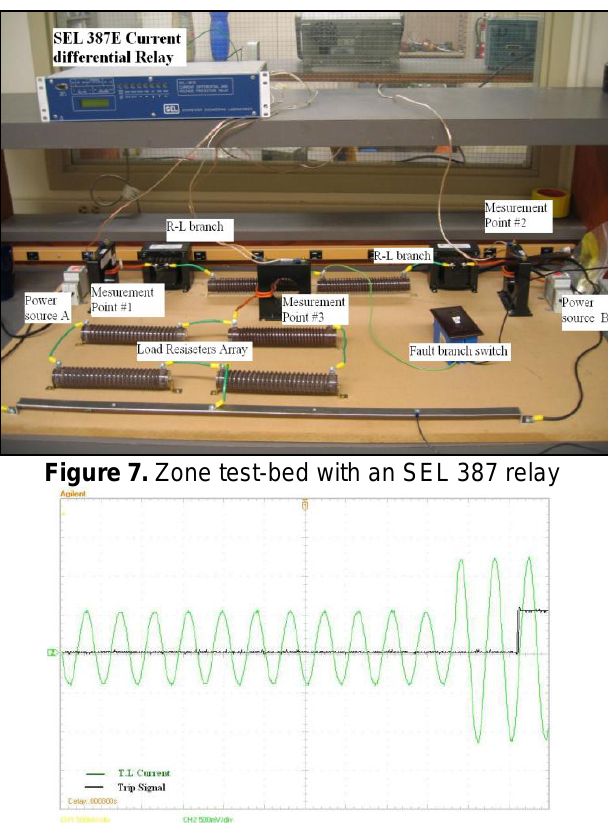
Figure 7. Zone test-bed with an SEL 387 relay